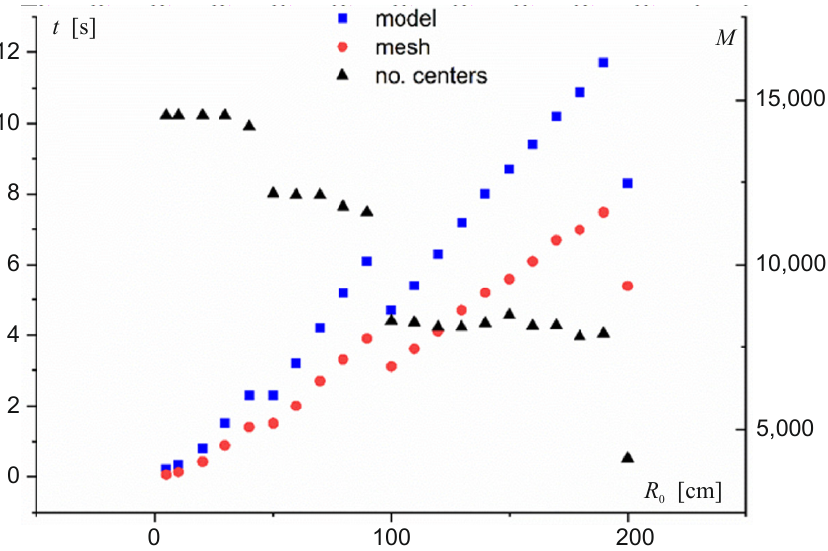
Figure 5. Time of model construction (model) and evaluation (mesh) depending on the initial radius. M indicates the number of approximation centres.